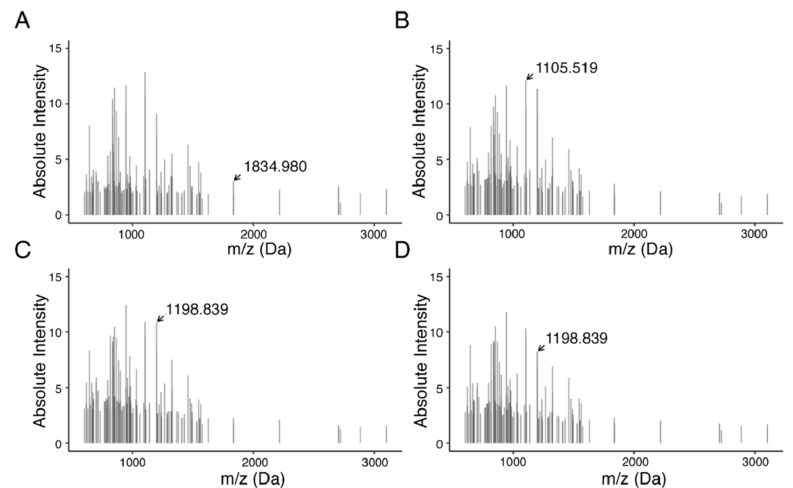
Figure 4. MALDI-Imaging-derived proteomics signature of 135 peptides from HGSOC subtype. Subtypes are shown as follows: ( A ) C1, mesenchymal; ( B ) C2, immunoreactive; ( C ) C4, differentiated; and ( D ) C5, proliferative. In total, feature selection resulted in 135 features in a mass range between m/z 600 and 3200. Highlighted m/z values indicate features with high differential in average intensities across subtypes.